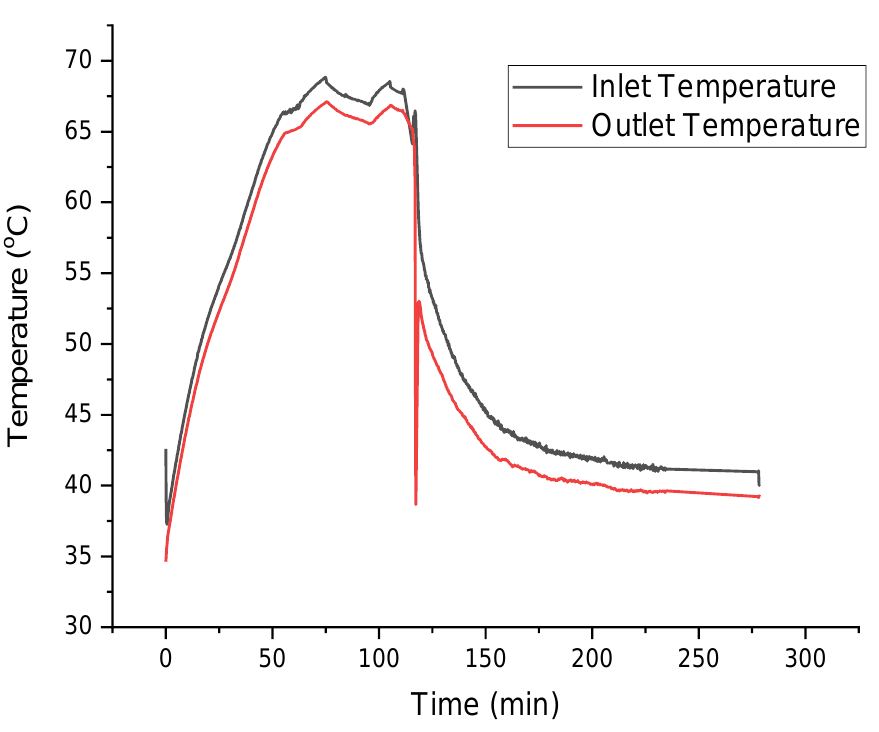
Figure 3. Temperature difference between the supply and return from the paraffin tank .